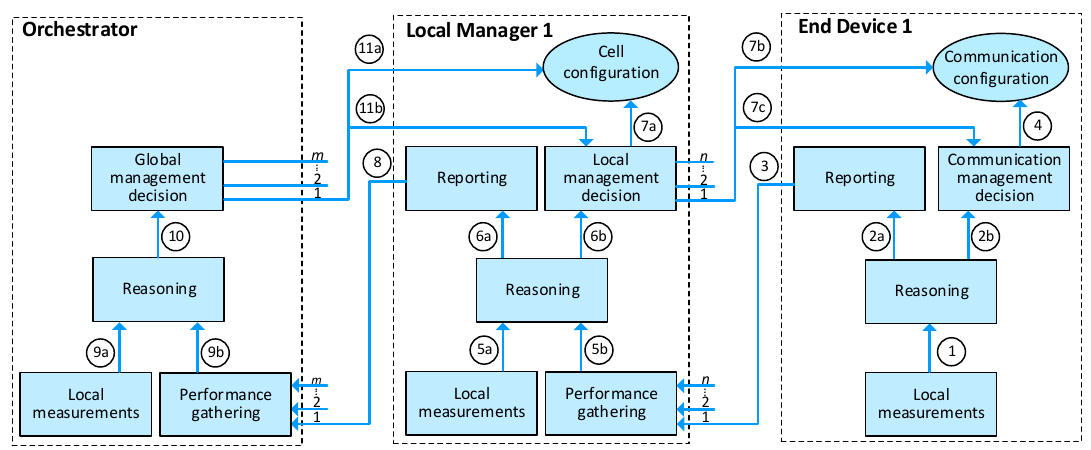
Figure 6. Hybrid communication management: interaction between management entities.